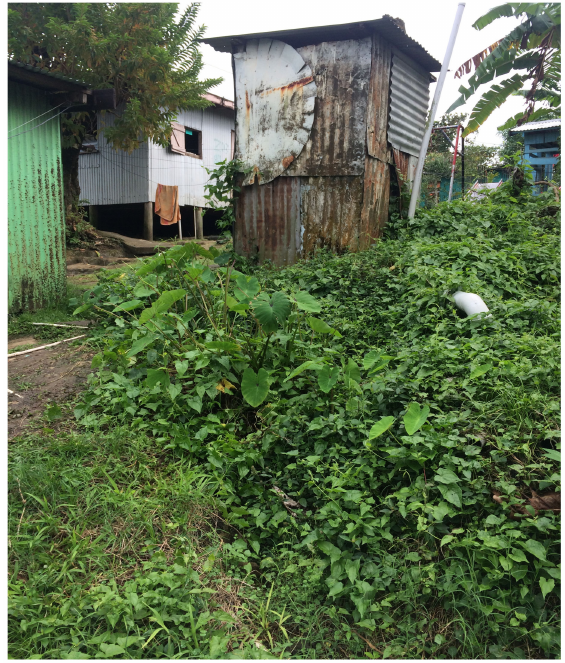
Figure 5. Household root crop gardens propagated directly on the toilet drainage area are common among Central Division typhoid cases (Photo credit: Aaron